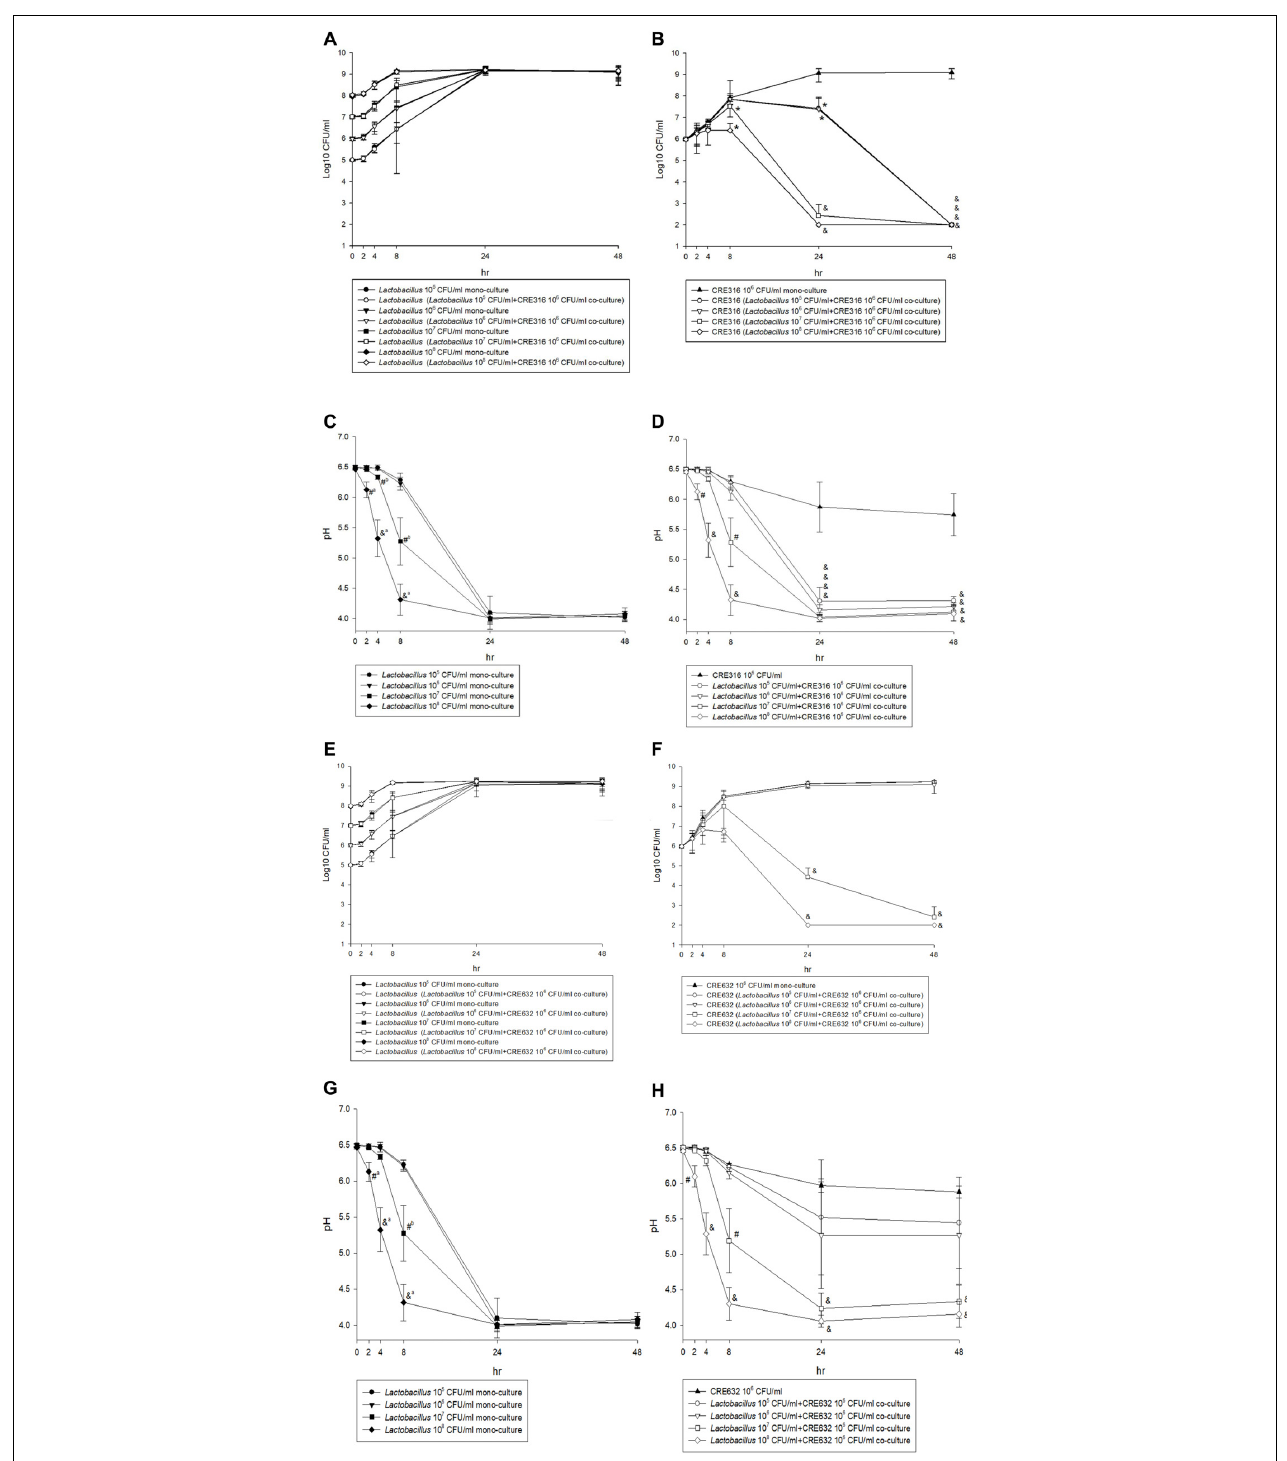
FIGURE 3 | (A,E) The CFU change of five different concentration (10 5 to 10 8 CFU/ml) Lactobacillus isolates after mono-culture or co-culture with CRE316/ 632 for 48 h. (B,F) The CFU change of CRE316/ 632 after mono-culture or co-culture with five different concentration (10 5 to 10 8 CFU/ml) Lactobacillus isolates for 48 h and comparison between mono-culture and co-culture. (C,G) The pH changes of five different concentration (10 5 to 10 8 CFU/ml) Lactobacillus isolates mono-culture for 48 h. (D,H) The pH changes of CRE316/ 632 after mono-culture or co-culture with five different concentration (10 5 to 10 8 CFU/ml) Lactobacillus isolates and comparison between mono-culture and co-culture. ( a Means the comparisons between 10 8 and 10 5 , 6 , 7 CFU/ml lactobacillus isolates. b Means the comparisons between 10 7 and 10 5 , 6 CFU/ml Lactobacillus isolates. ∗ P -value < 0.05, # P -value < 0.001, & P -value < 0.0001).